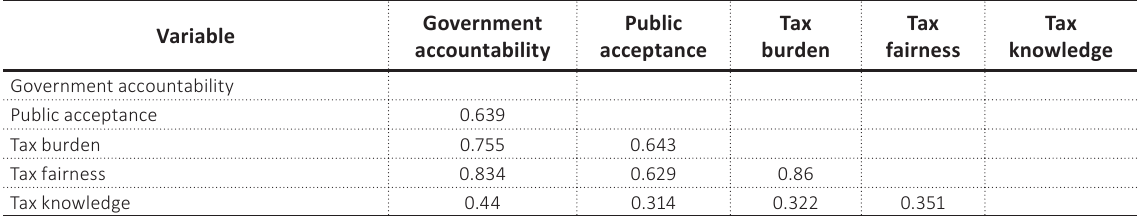
Table 5. Discriminant validity (HTMT ratio of correlations method criterion)